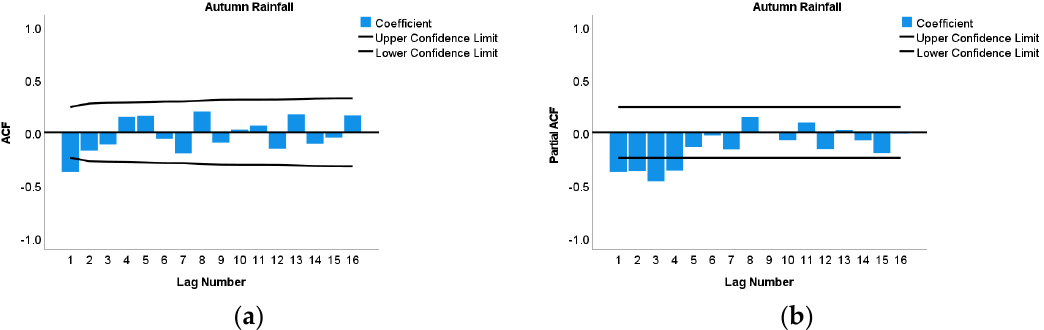
Figure 5. ( a ) Autocorrelation function (ACF) plot of rainfall in Albany and ( b ) partial autocorrelation function (PACF) plot of rainfall in Albany.